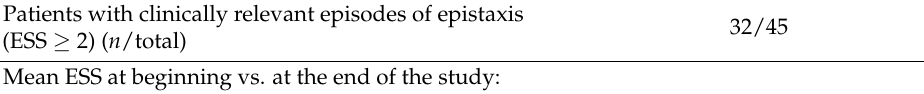
Table 3. Epistaxis severity score (ESS) during the study. Patients with clinically relevant episodes of epistaxis